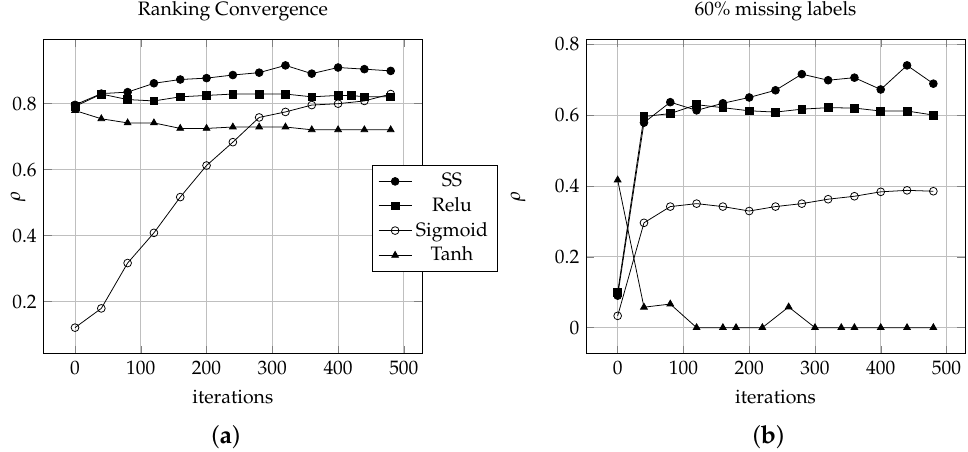
Figure 2. Comparison of activation functions ranking of iris dataset. ( a ) has a complete labels. ( b ) has 60% missing